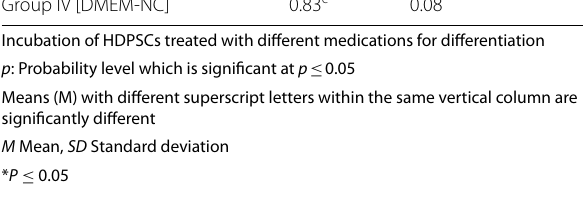
Table 3 Alkaline phosphatase assay after 72 h